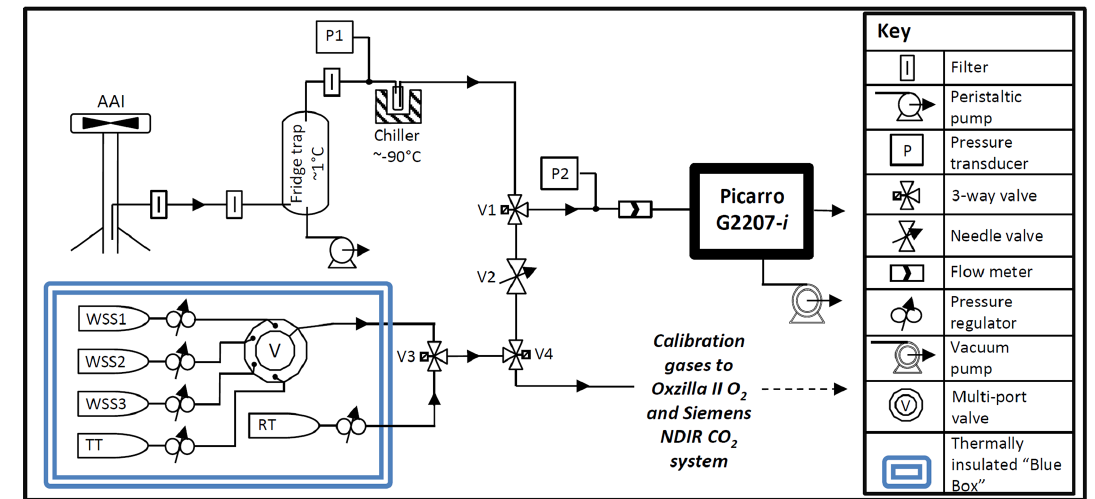
Figure 1. Gas handling diagram of the Picarro G2207- i installed at WAO. (AAI, aspirated air inlet; WSS, working secondary standard; RT, reference tank; TT, target tank). Calibration gases were shared with the established O 2 and CO 2 system (using V4), but the established system has its own AAI, pump, drying system, and pressure and flow control (not depicted